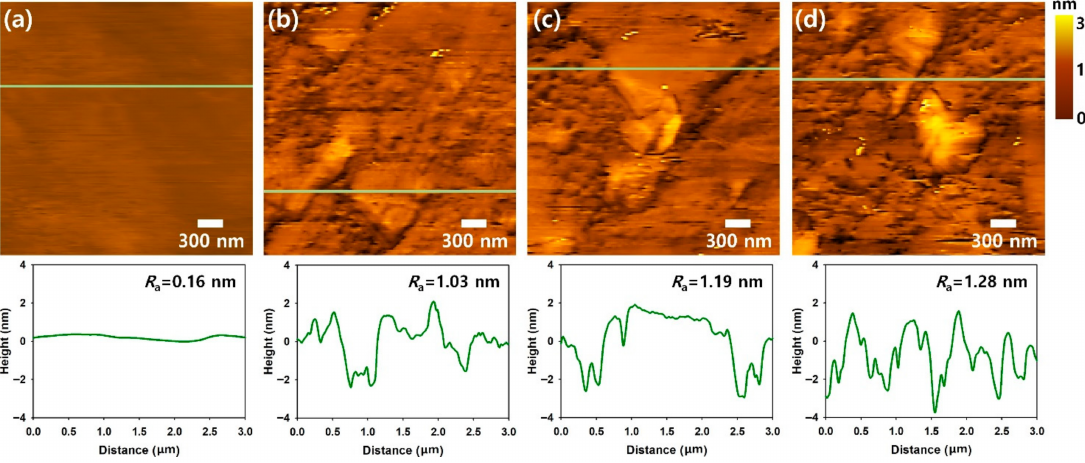
Figure 2. Tapping-mode AFM topographies of ( a ) Cu foil substrate, ( b ) pristine G, ( c ) O 2 -G and ( d ) N 2